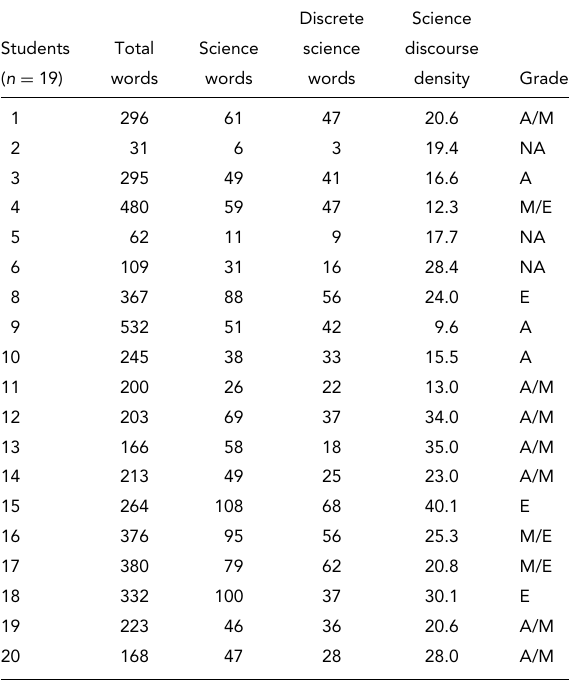
Summative Test Scores